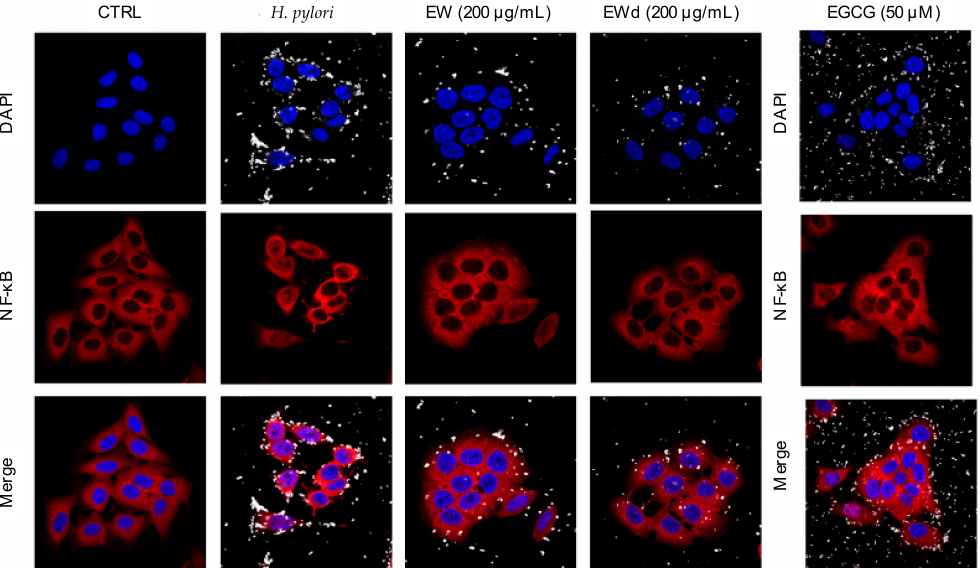
Figure 6. Immunofluorescence confocal microscope images of NF- κ B p65 in GES-1 cells treated with the stimulus H. pylori ( H. pylori :cell ratio 50:1) and the non-digested ethanol-water extract of Rhus coriaria L. (EW 200 µ g/mL) or digested ethanol-water extract of Rhus coriaria L. (EWd 200 µ g/mL) for 1 h. The reference compound used was EGCG 50 µ M. Cell nuclei are represented in blue, the bacterium in white, and p65 subunit in red. NF- κ B, nuclear factor kappa B; DAPI, 4 (cid:48) ,6-diamidino-2- phenylindole; CTRL, control.